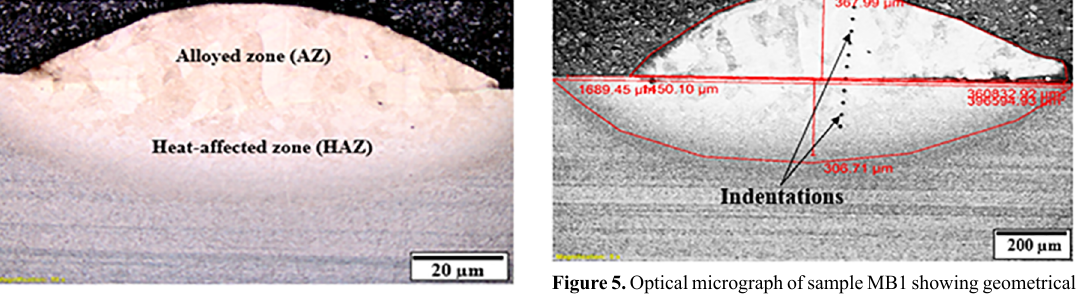
Figure 3. Micrograph of full single track deposit, magnification 50x.